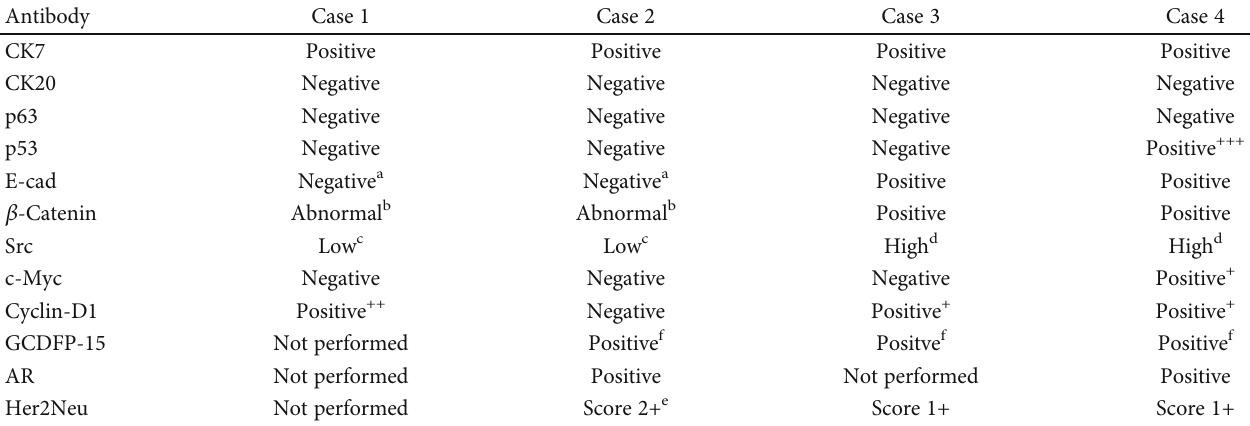
a Negative: < 10% of the tumor cells staining for E-cadherin. b Abnormal: heterogeneous, incomplete membranous staining for B-catenin. c Decreased/low Src cytoplasmic staining in less than 25% of tumor cells. d High cytoplasmic Src expression in 25%-75%of tumor cells. e Her2 FISH was negative. f Performed in an outside facility. + Focal positivity (1%- < 25% of tumor cells). ++ Moderate positive expression in > 25%- < 50% of tumor cells. +++ Strong positive immunoreactivity seen in > 50% of tumor